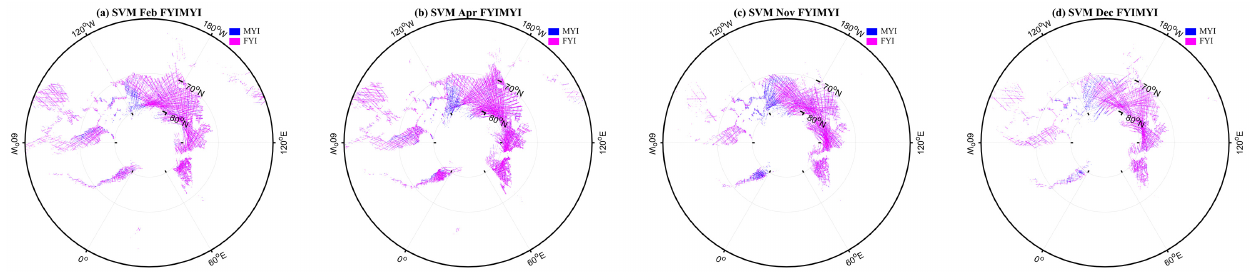
Figure A16. SVM for FYI-MYI classification using the data in February as the training set. The data in ( a ) March, ( b ) April, ( c ) November, and ( d ) December are used as the test set in turn.